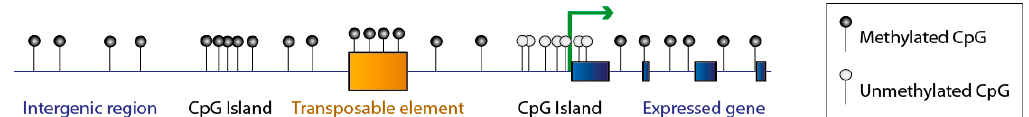
Figure 1. Genome-wide distribution of DNA methylation in mammalian species. DNA methylation occurs symmetrically on CpG sites: to simplify, only one DNA strand is shown on this figure. The mammalian genome has a low frequency of CpGs, but the majority of these are methylated (black lollipops) in intergenic regions, repeated elements and transposable elements, and in gene bodies. Conversely, CpG islands are rich in CpGs and are usually protected from DNA methylation (white